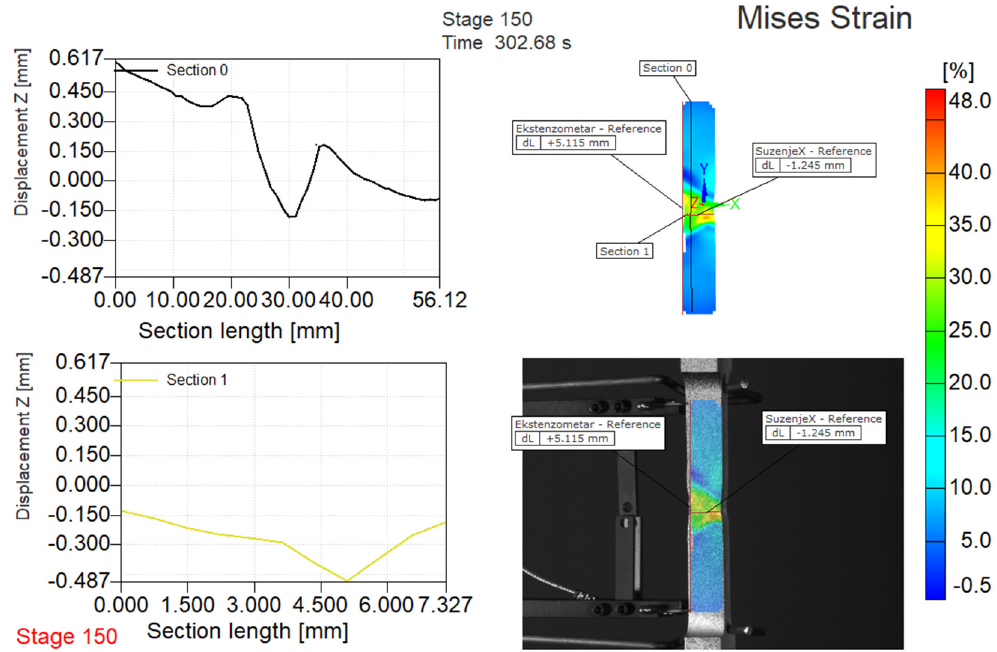
Figure 4. Analysis of changes in the characteristic dimensions of the specimen C1-1.